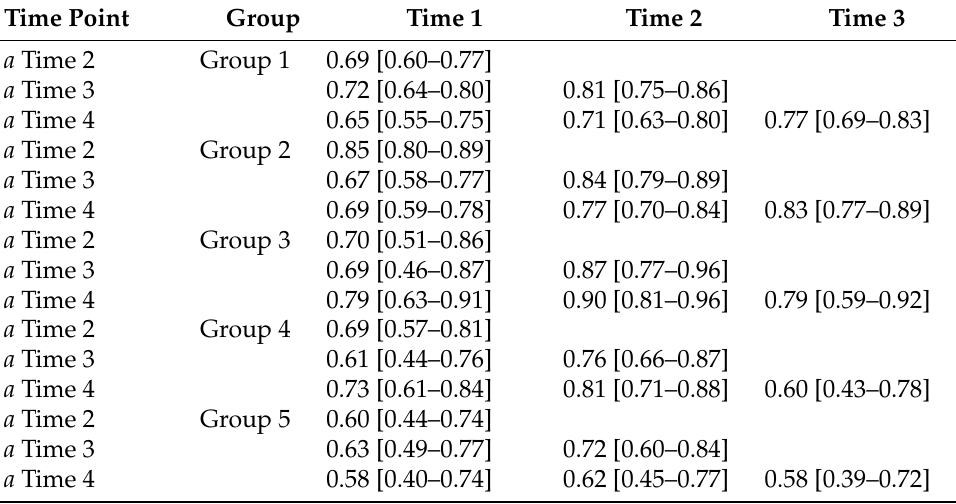
Table A8. Correlation matrix of boundary separation across four time points split by groups.